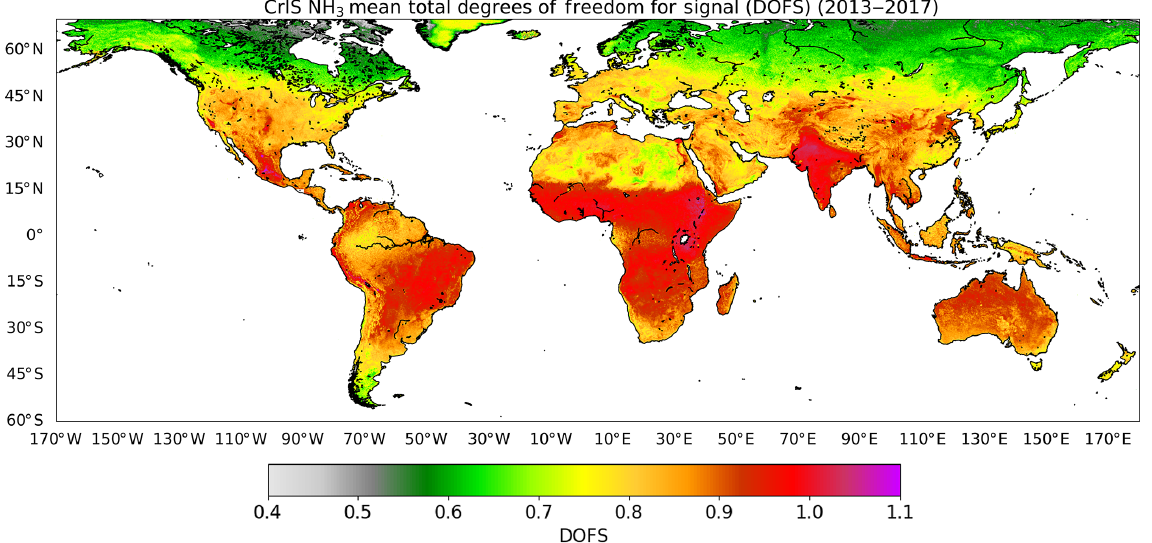
Figure 6. CrIS 5-year (2013–2017) global mean of DOFSs corresponding to the retrievals in Fig.